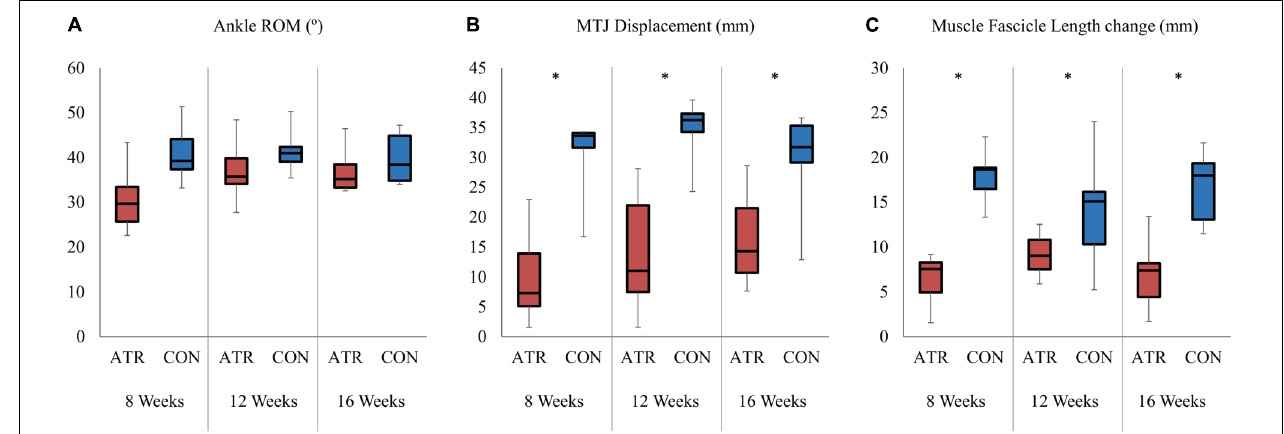
FIGURE 3 | Absolute changes of selected parameters between maximal plantarflexion and maximal dorsiflexion for both the on the ATR-injured and contralateral (CON) sides at each measurement point. Significant levels for the overall effect of leg type as determined by a factorial repeated-measures ANOVA ( p < 0.01) are indicated with *. (A) Range of motion of the ankle ( ◦ ). (B) Absolute displacement of the musculotendinous junction (MTJ, in mm). (C) Absolute change in the medial gastrocnemius fascicle length (mm).